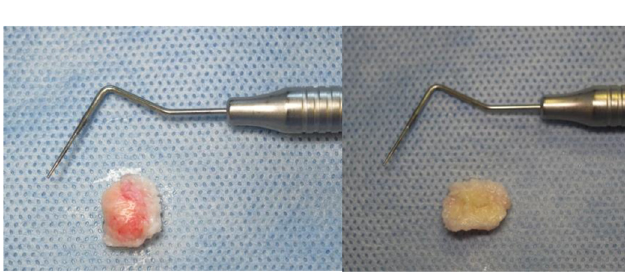
Fig. 3. External surface of the anatomical part with a bony aspect and Intern surface of the anatomical part with a cartilaginous appearance.